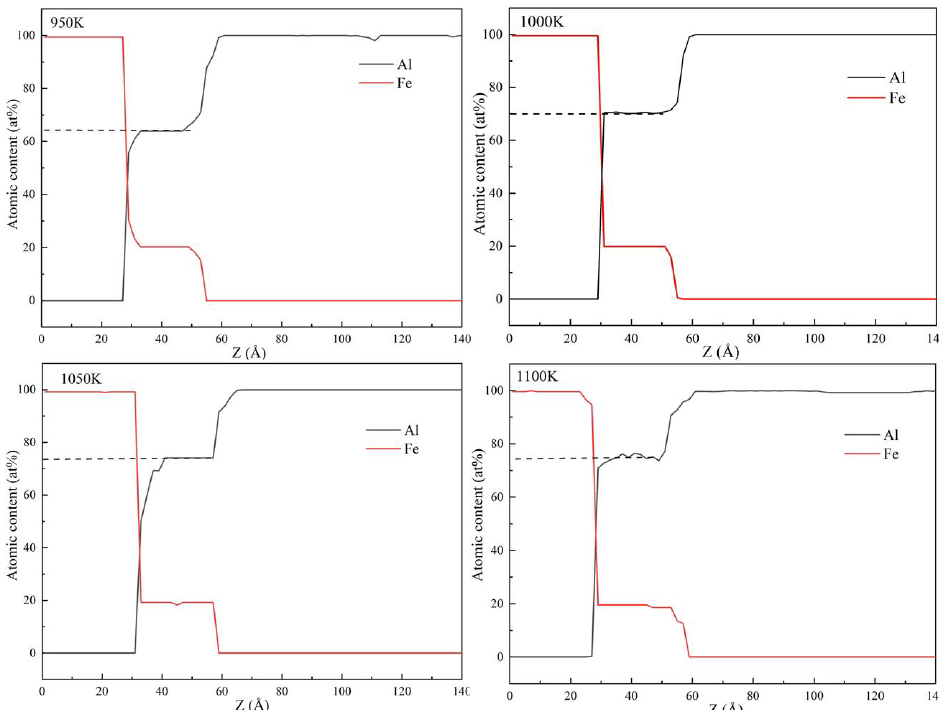
Figure 6. Atomic diffusion concentration distribution at different temperatures.